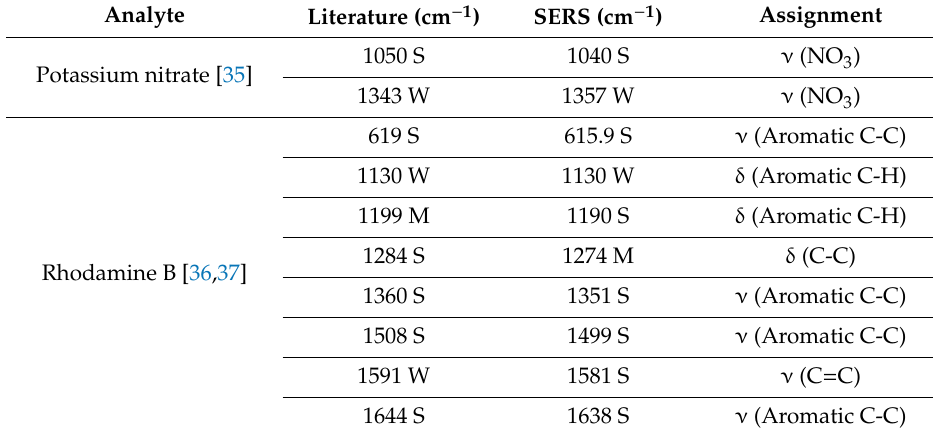
Figure S1: Surface profile calculation of the middle concave segment of the freeform-segmented reflector, Figure S2: Schematic design of all segments of the reflector, Figure S3: Two configurations of the reflector and microfluidic chip design, Figure S4: Raman response of water and ethanol in the fluidic channel, Figure S5: Raman spectra of urea and potassium nitrate solutions with di ff erent concentrations, Figure S6: Main Raman bands of urea and potassium nitrate, Figure S7: Surface enhanced Raman spectra of 0.01 mM Rhodamine B, 0.01 mM urea, 0.01 mM potassium nitrate solutions and water, Figure S8: Baseline corrected Raman spectra of 0.01 mM Rhodamine B (RhB), 0.1 mM urea, 0.1 mM potassium nitrate solutions obtained with our microfluidic system in combination with the SERS